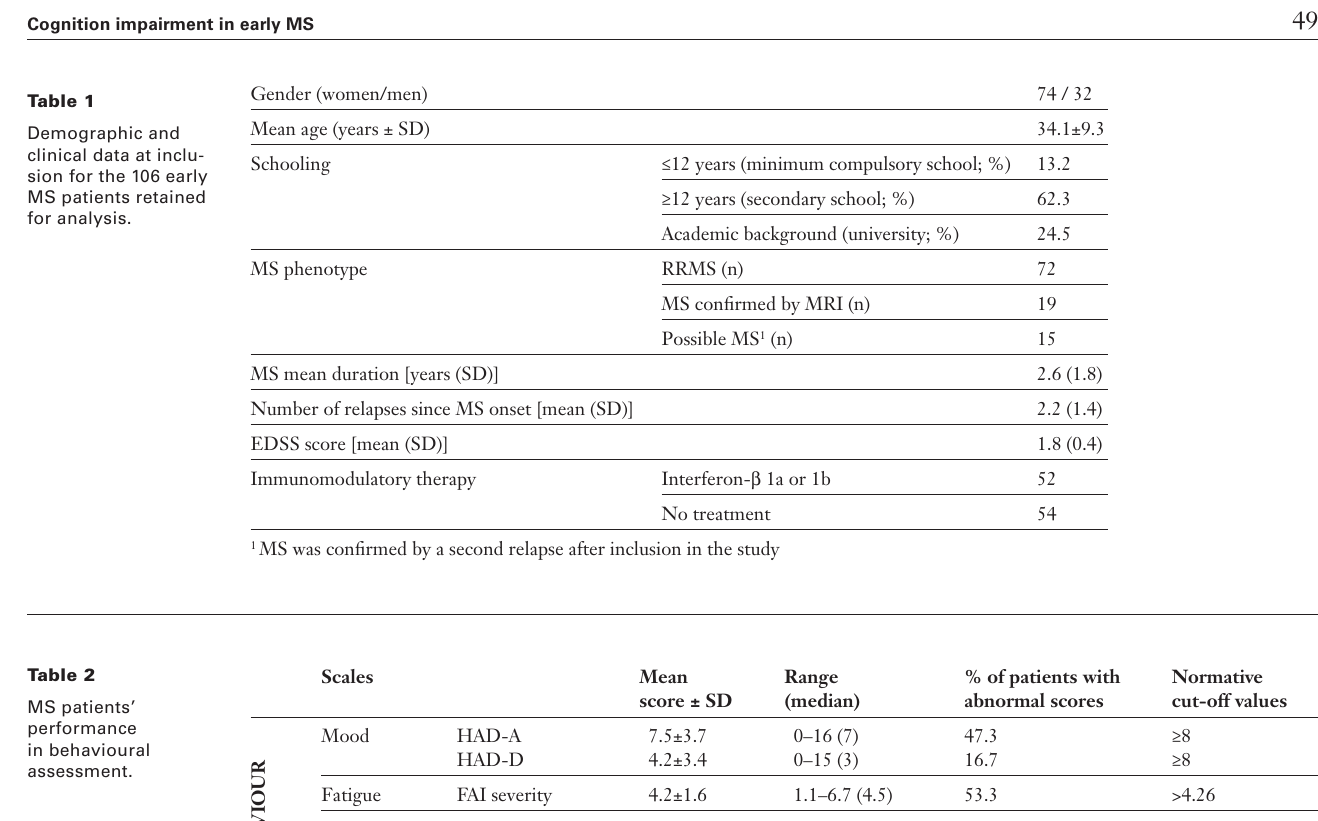
MS patients’ performance in behavioural